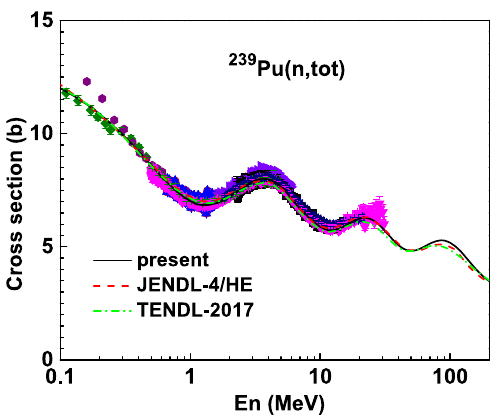
Figure 1. Calculated total cross section (solid line) for n + 239 Pu reaction compared with the experimental data and the evaluated data from JENDL-4 / HE (dashed line) and TENDL (dash-dotted line).